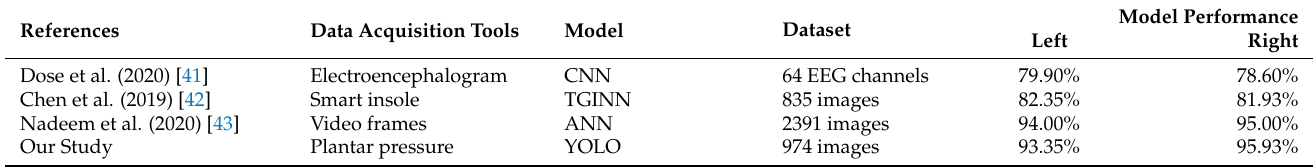
Table 2. The comparison of studies in left and right foot prediction using deep learning